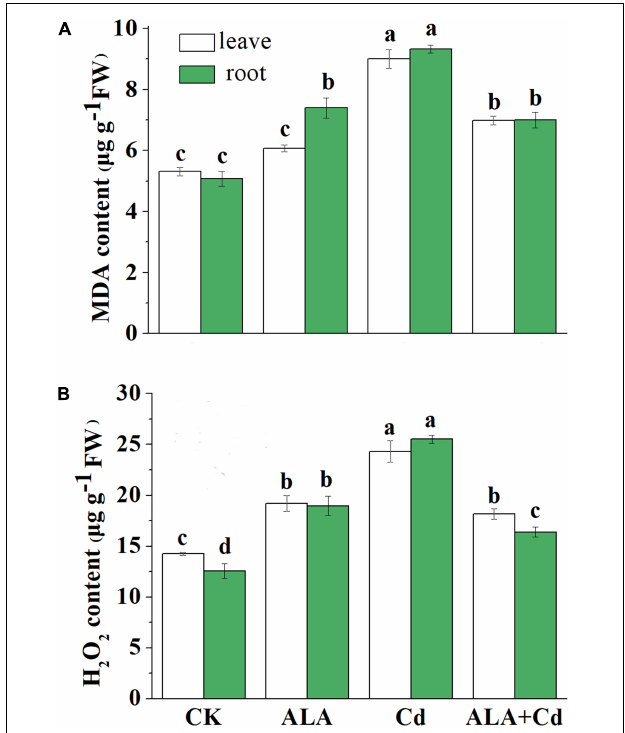
FIGURE 5 | Effects of ALA under Cd stress on contents of MDA (A) and H 2 O 2 (B) of cabbage. The seedlings were treated as in Figure 1 . The mean ± SE are shown ( n ≥ 3). Different letters indicate significant difference among the treatments ( P <